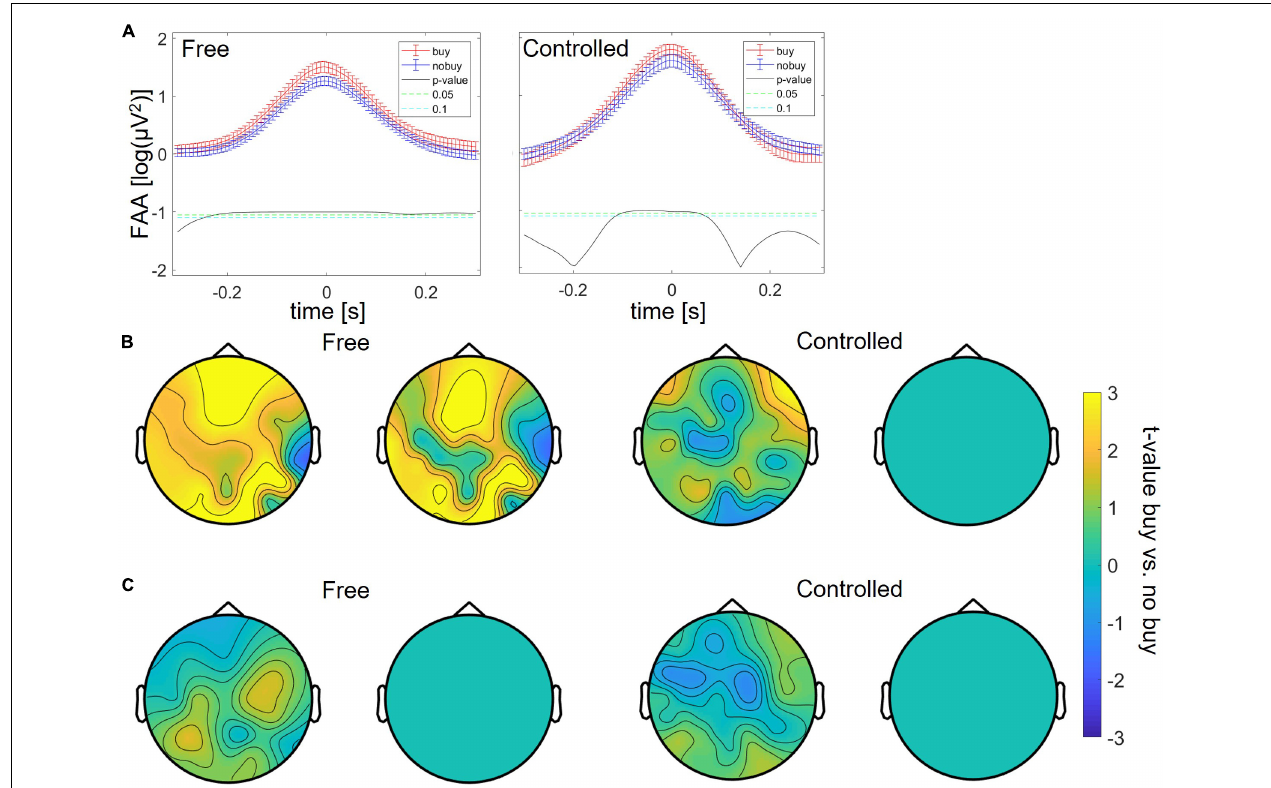
FIGURE 6 | Differences between buying and no-buying trials in Study 2 for free and controlled search, (A) increased frontal alpha at FAA peaks, (B) increased frontal theta at theta peaks, and (C) decreased occipital alpha at FAA